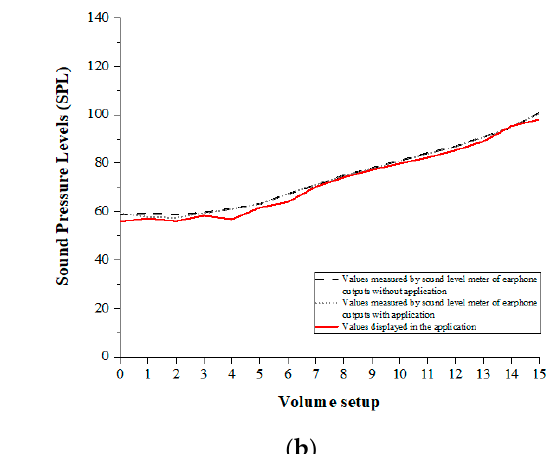
Figure 1. A flow chart showing the components of background service ( a ) and active processing ( b ), and a screenshot of the measurement application used in the current experiment using the developed application ( c ).